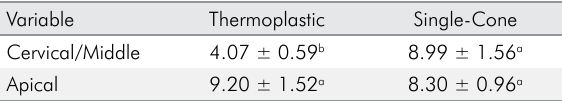
Table. Percentage of voids in flattened root canals filled with Bio-C Sealer using thermoplastic or single-cone techniques (means and standard deviations).